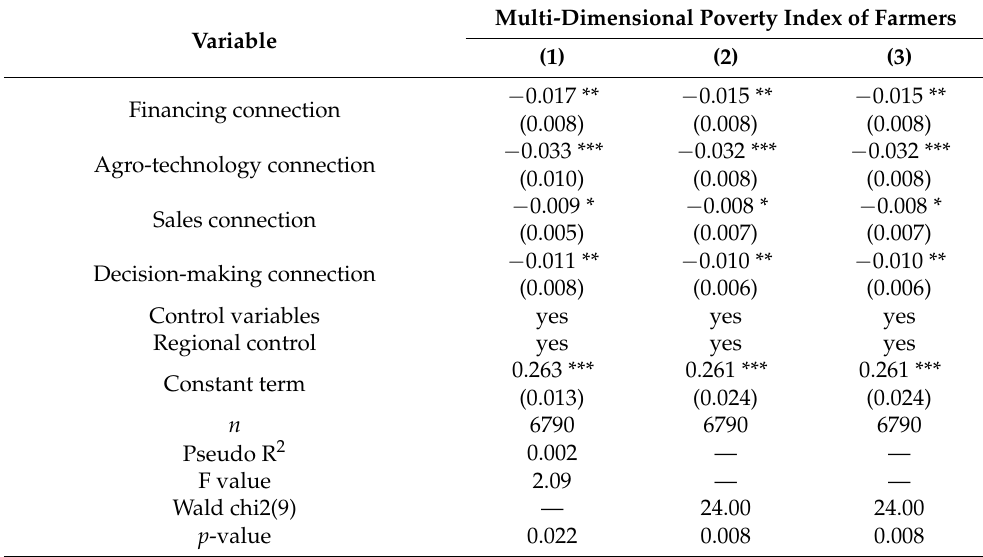
Table 4. The multidimensional poverty reduction effect of benefit coupling: endogeneity test.